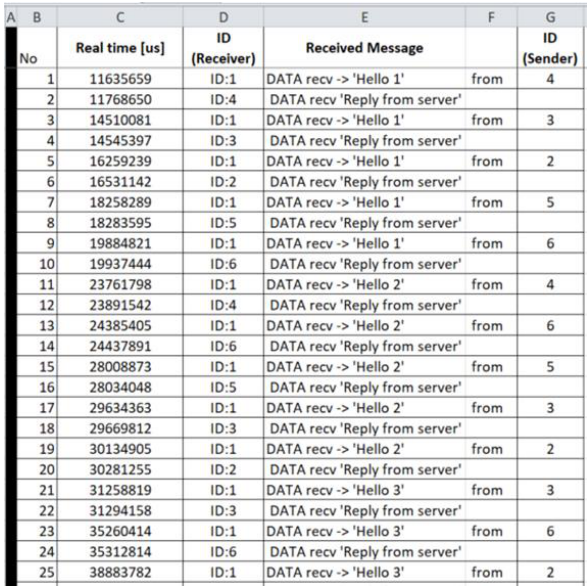
Figure 13. Benign “recv.csv”— 1 to 25 records.